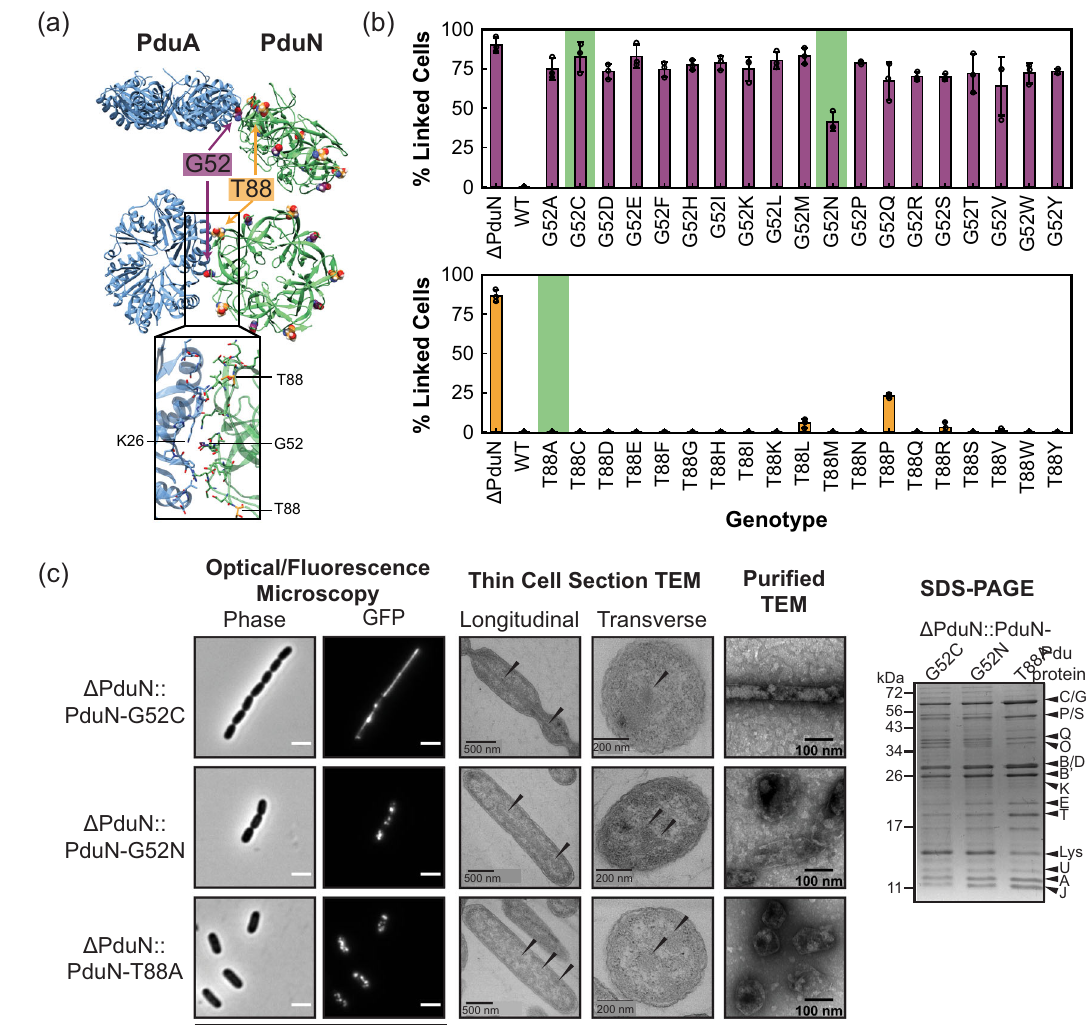
Fig. 7 Interrogating the mutability of two PduN residues using the linked cell phenotype readout. a Ribbon structure of the PduA-PduN interface (taken from the 40° bending angle simulations shown in Fig. 3), highlighting the two residues mutated in this work--glycine 52 (G52) in purple, which is buried in the interface, and threonine 88 (T88) in yellow, which sits at the top of the PduA-PduN interface. b Percent linked cell populations (de fi ned as in Fig. 6) for strains expressing the pdu operon with all possible point mutations at position 52 in PduN (top) and position 88 in PduN (bottom). Bars represent mean percentage of linked cells over three biological replicates. Error bars indicate standard deviation in percent linked cells over three biological replicates. At least 100 cells were counted in total for each point mutant. The speci fi c number of cells counted for each point mutant is available in Supplementary Table 2. Green highlights indicate point mutants that were selected for more detailed validation of Pdu MCP versus Pdu MT formation. c Detailed characterization of the Pdu compartment or tube structures formed in the presence of different PduN point mutants. Scale bars in optical and fl uorescence micrographs are 2 μ m. Arrows in thin cell section micrographs indicate protein-rich structures. Coomassie-stained SDS-PAGE gel is labeled with the bands expected for various Pdu proteins or lysozyme (Lys). Similar results were observed across three independent biological replicates for optical microscopy and SDS-PAGE experiments. TEM imaging of puri fi ed compartment structures and of thin cell sections was only conducted once. Source data are provided as a Source Data fi across compartment systems — in the absence of vertex proteins, β -carboxysomes form elongated structures similar to Pdu MTs 34 , but α -carboxysomes predominantly form regular icosahedra 35 .